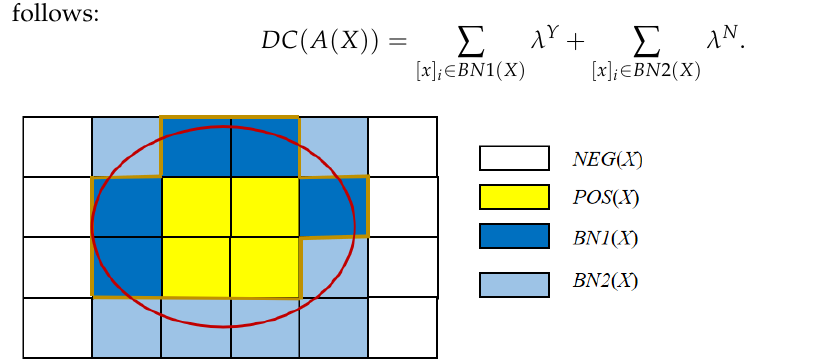
Figure 1. The approximation of rough sets (surrounded by the broken